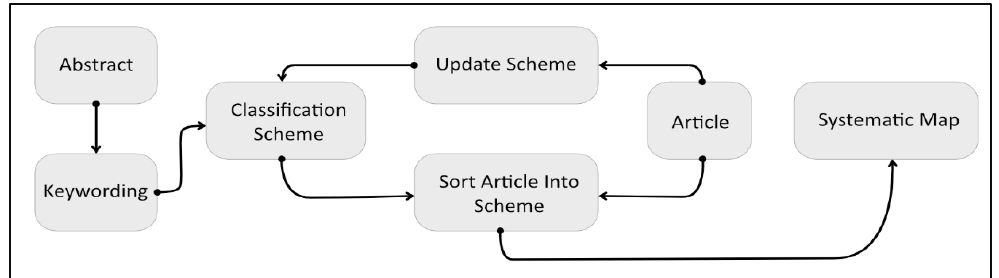
Figure 3. Paper classification scheme.